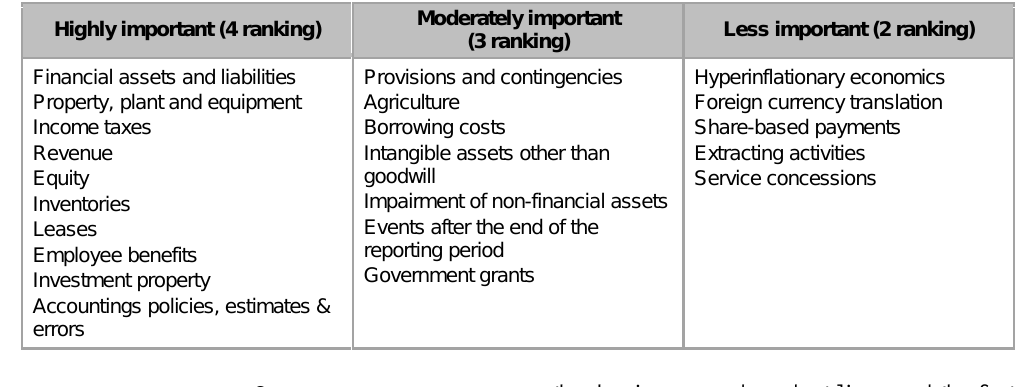
Classification of components of IFRS for SMEs relating to specific types of transactions in order of